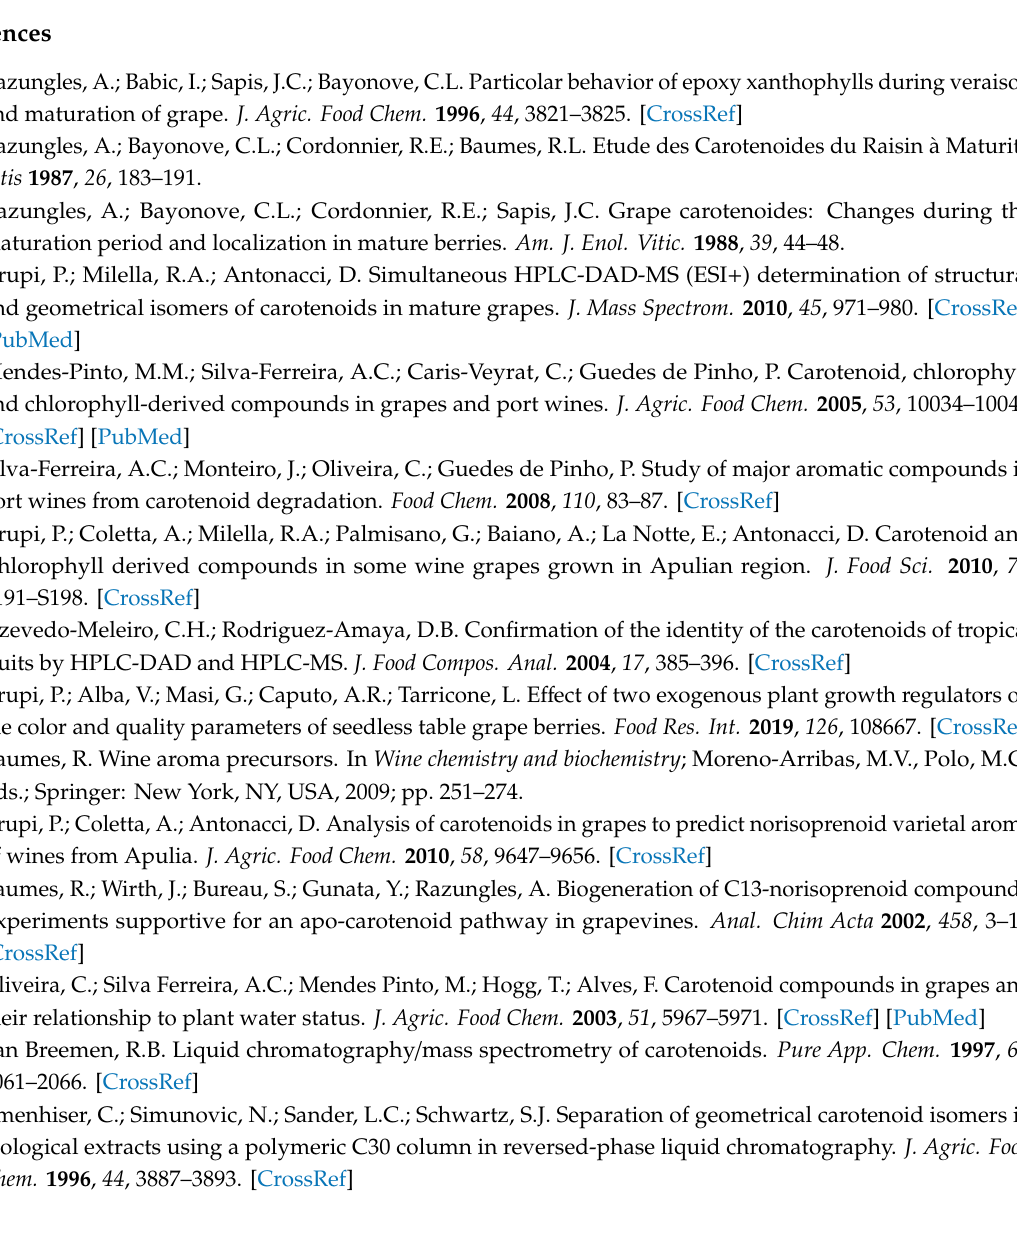
Figure S1: Extraction yields of ( a ) Negro Amaro and ( b ) Primitivo samples, Table S1: Validation parameters, linearity, repeatability (r), LOD and LOQ for HPLC-DAD